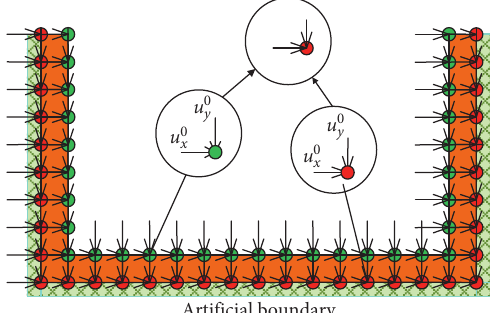
Figure 1: Artificial boundary